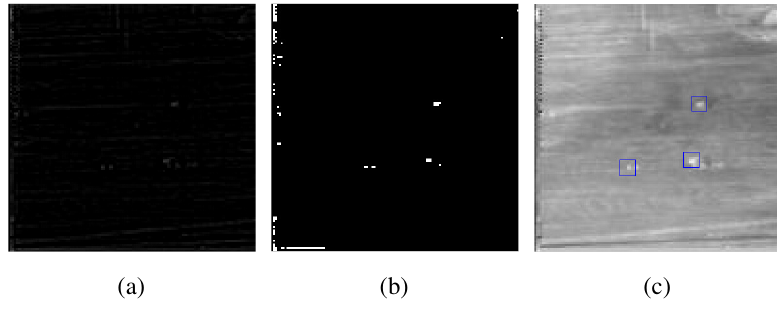
Figure 5. Figures of two-dimensional least mean square (TDLMS). ( a ) saliency map of TDLMS method; ( b ) result of threshold operation; ( c ) final result marked by blue block. Top-hat is a mathematical morphology operation based on two basic operations: Dilation and